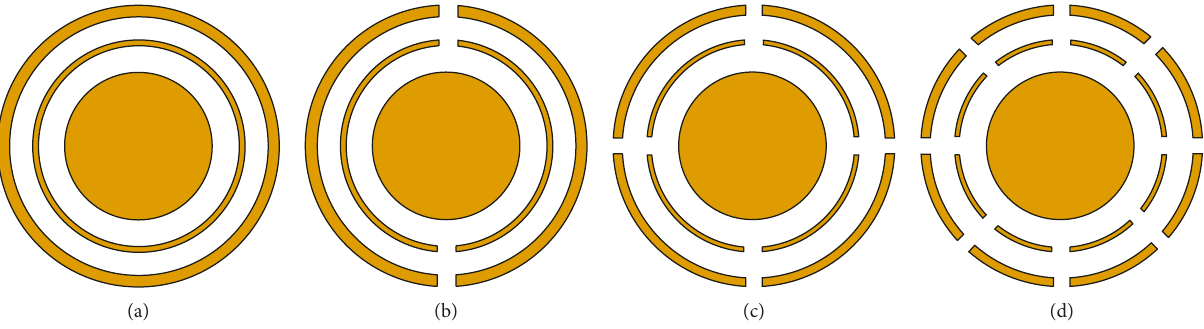
Figure 9: Different numbers of the strips. (a) Strip 1. (b) Strip 2. (c) Strip 3. (d) Strip